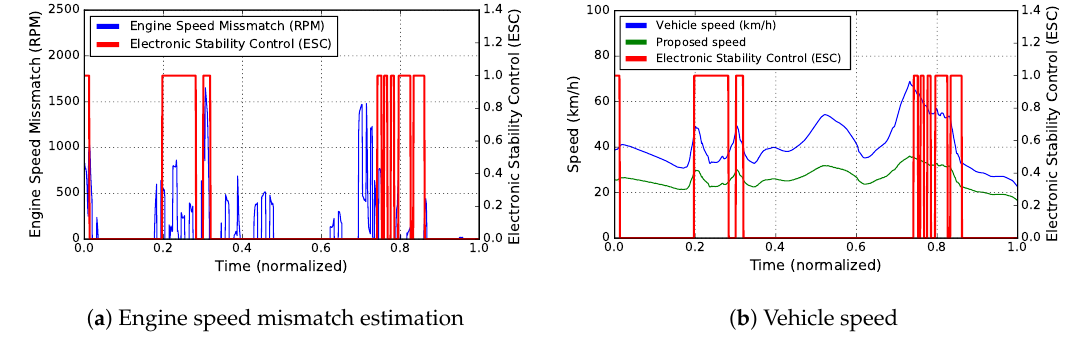
Figure 8. Speed validation utilizing vehicular information in a test track